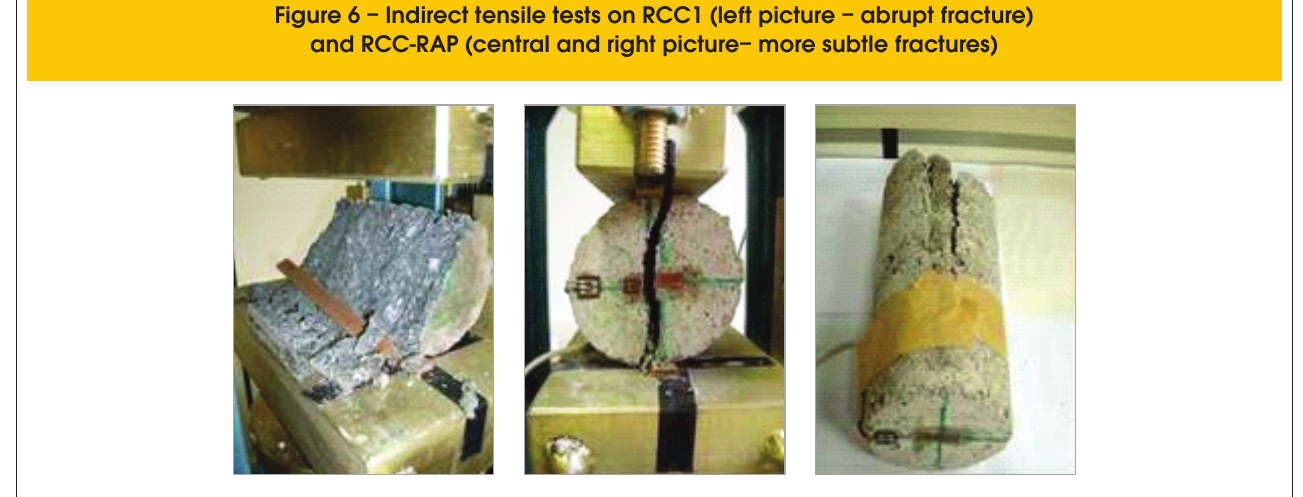
Figure 6 – Indirect tensile tests on RCC1 (left picture – abrupt fracture) and RCC-RAP (central and right picture– more subtle fractures)